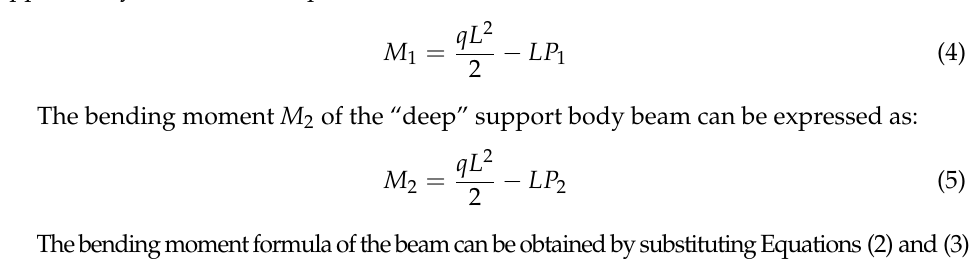
Figure 9. Simply supported beam model of roof.